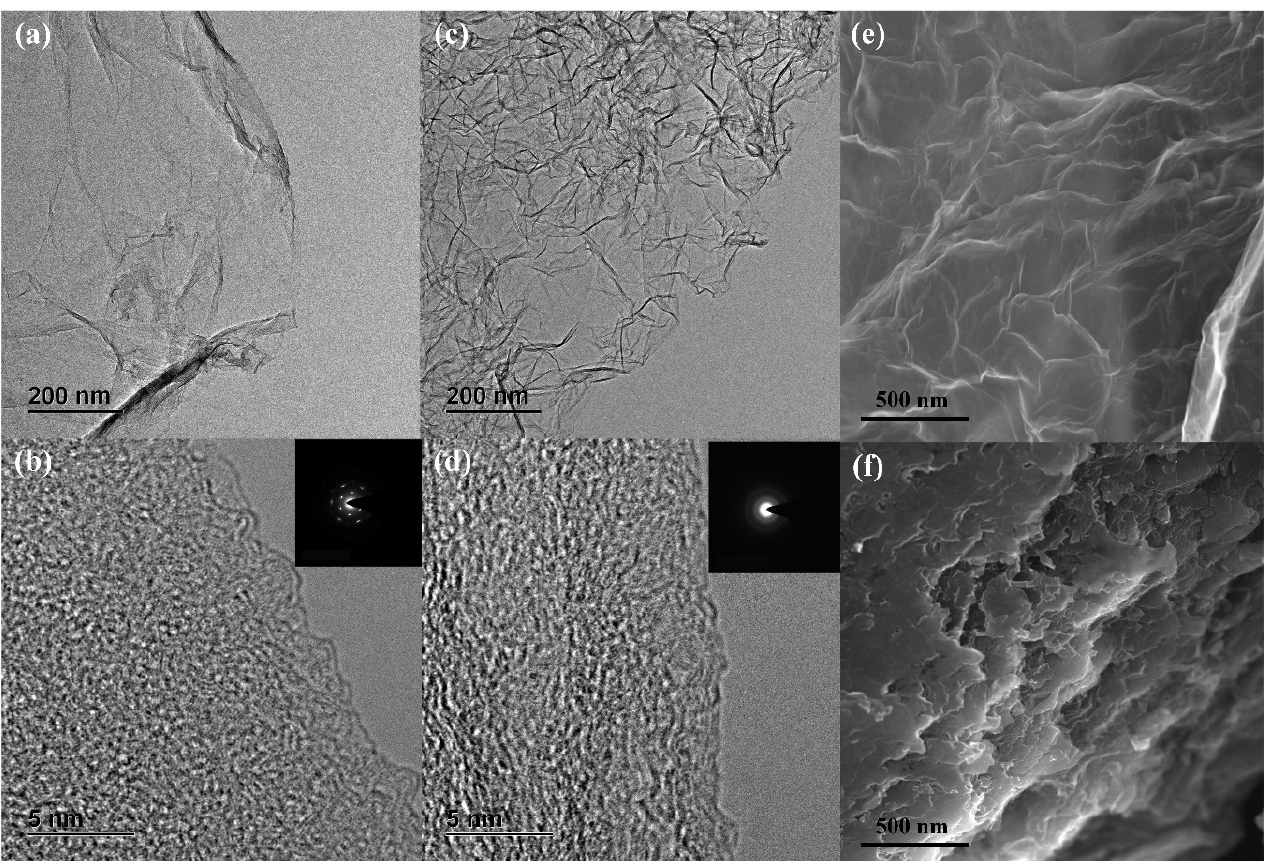
Figure 1. ( a , c ) Low resolution TEM images of rGO and Azo F –rGO, ( b , d ) high resolution TEM images of rGO and Azo F -rGO with FFTs, and SEM images of ( e ) rGO and ( f ) Azo F –rGO.